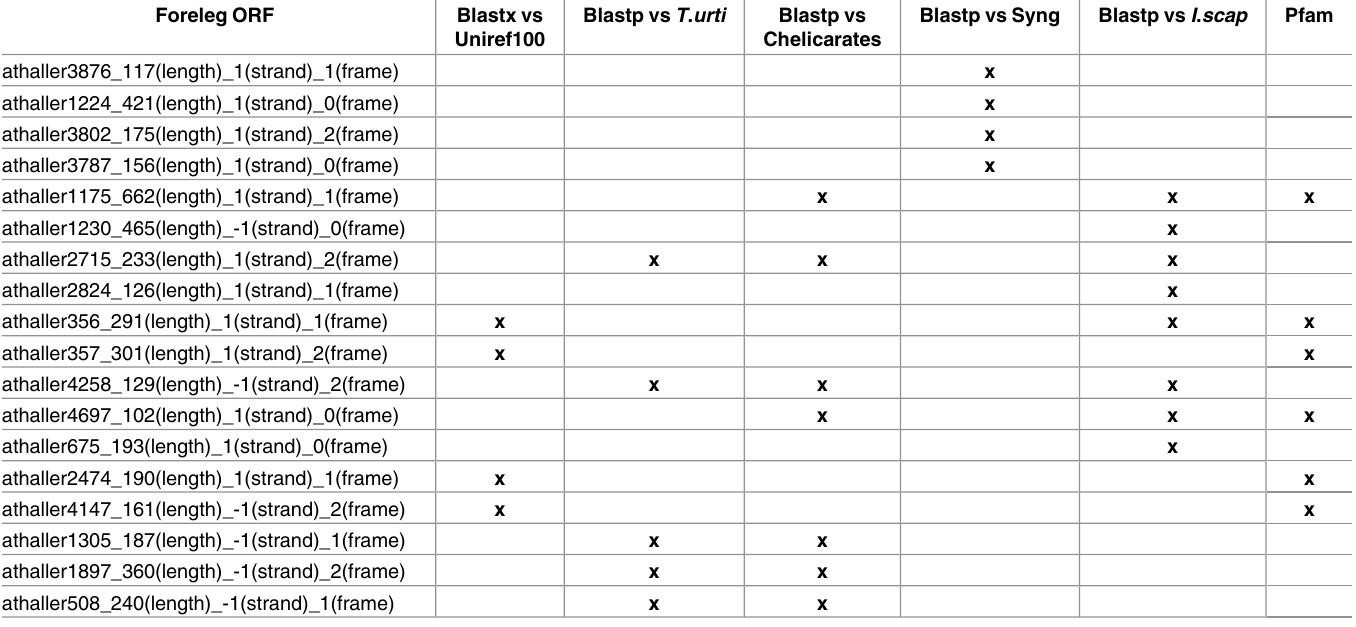
Table 2. ORFs predicted as GPCRs by any of the alignment-based tools. Foreleg ORF Blastx vs